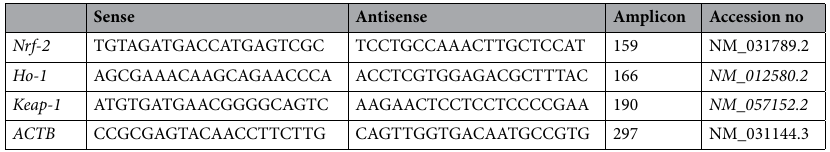
Table 1. The primer set for the measured genes. Nrf-2 nuclear factor-erythroid 2-related factor 2, Ho-1 heme oxygenase-1, Keap-1 kelch like ECH associated protein 1, ACTB ACTB actin beta